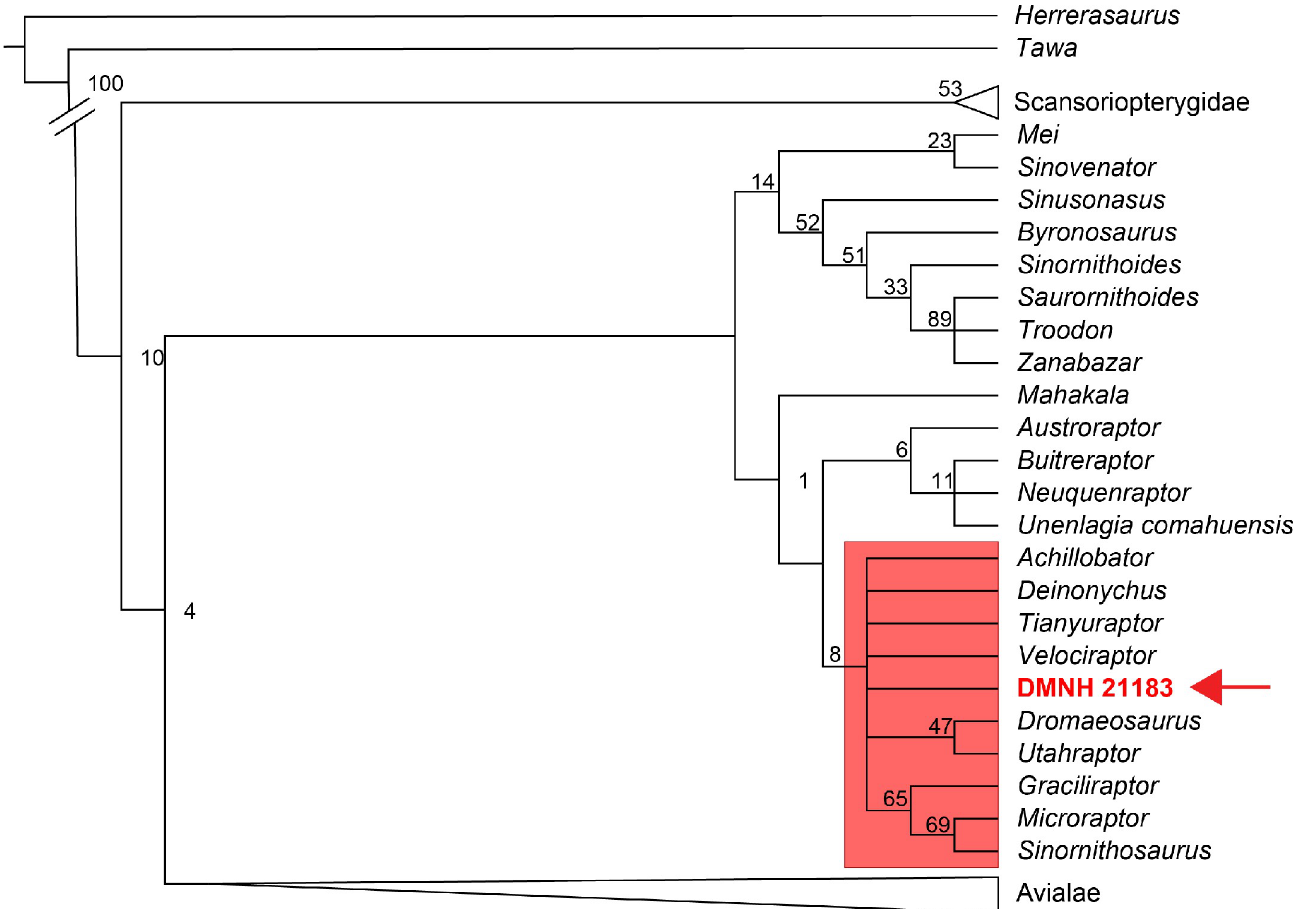
Fig 5. Phylogenetic position of DMNH 21183. Strict consensus topology of the shortest trees recovered by the parsimony analyses of the phylogenetic dataset of Lee et al. [33] with the addition of DMNH 21183 (384 MPTs, 6043 steps, CI = 0.244, RI = 0.587). The main clades of Theropoda outside Deinonychosauria are collapsed for space constraints. Full topology available in S4 Fig. Numbers adjacent to nodes are the bootstrap values. Red box highlights the node containing DMNH 21183 (red arrow).